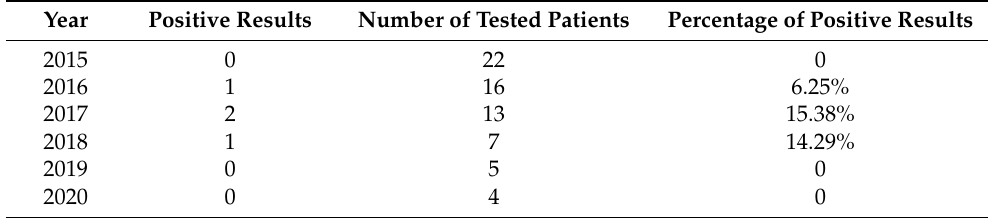
Table 12. Anti-mannan Candida antibodies in PCICU patients.